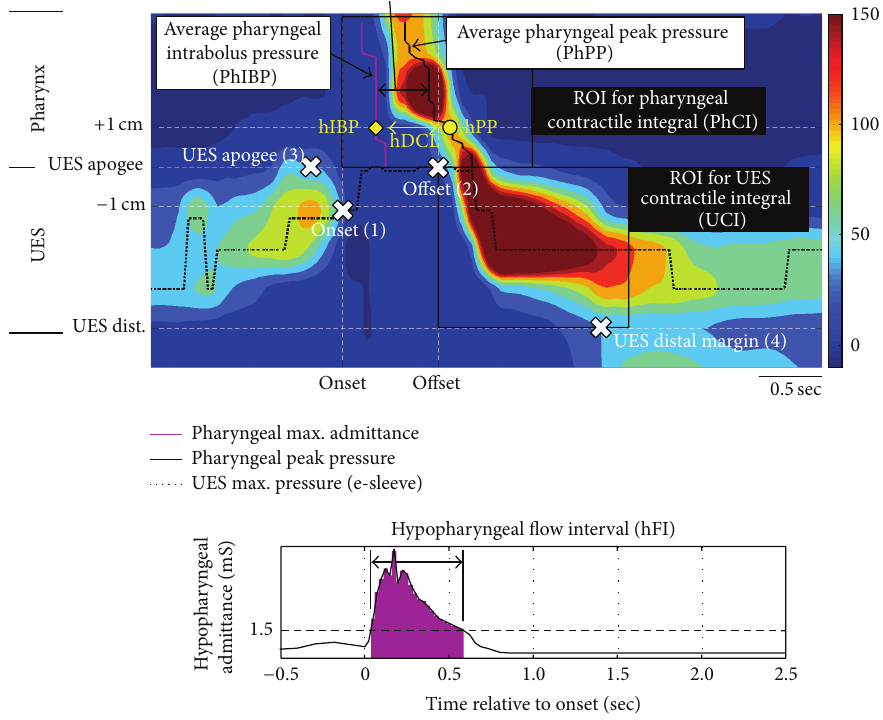
Figure 2: Software-derived variables of swallowing function. To operate analysis software, the analyst opened a colour pressure isocontour plotofeachswallowfile.Analyststhendefinedfourspace-timelandmarksontheplot(whitecrosses).Guidedbydefinitionoftheselandmarks, the software then automatically generated values for swallow function variables measuring contractility (PhPP, hPP, and PhCI), intrabolus distension pressure guided by maximum admittance/nadir impedance (PhIBP, hIBP), flow timing (PhDCL, hDCL), and bolus presence (hFI).